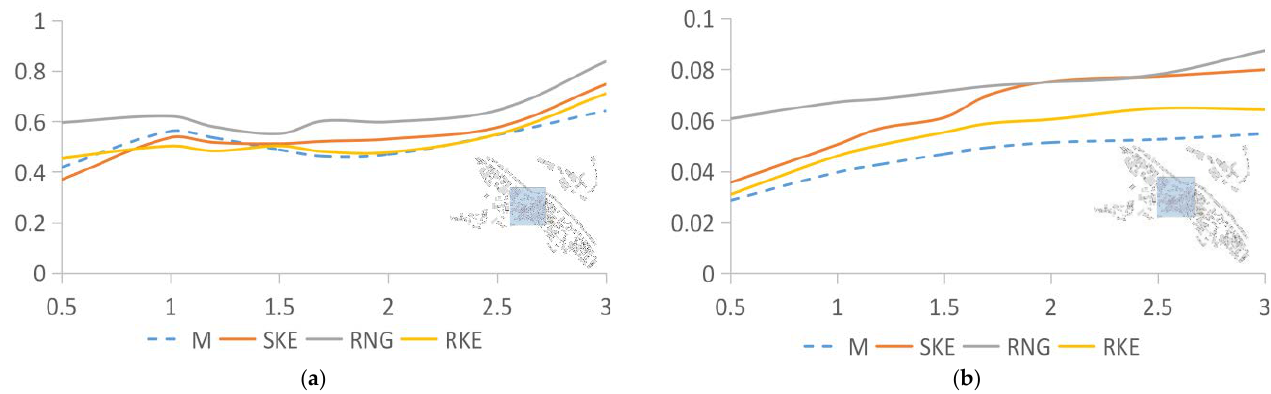
Figure 7. Analysis of measured values and data simulated using SKE, RNG, and RKE in an area with a building density of 35.71%. ( a ) Wind speed comparison between SKE, RNG, RKE, and the measured data. ( b ) Comparison of turbulence intensity between SKE, RNG, RKE, and the measured data.